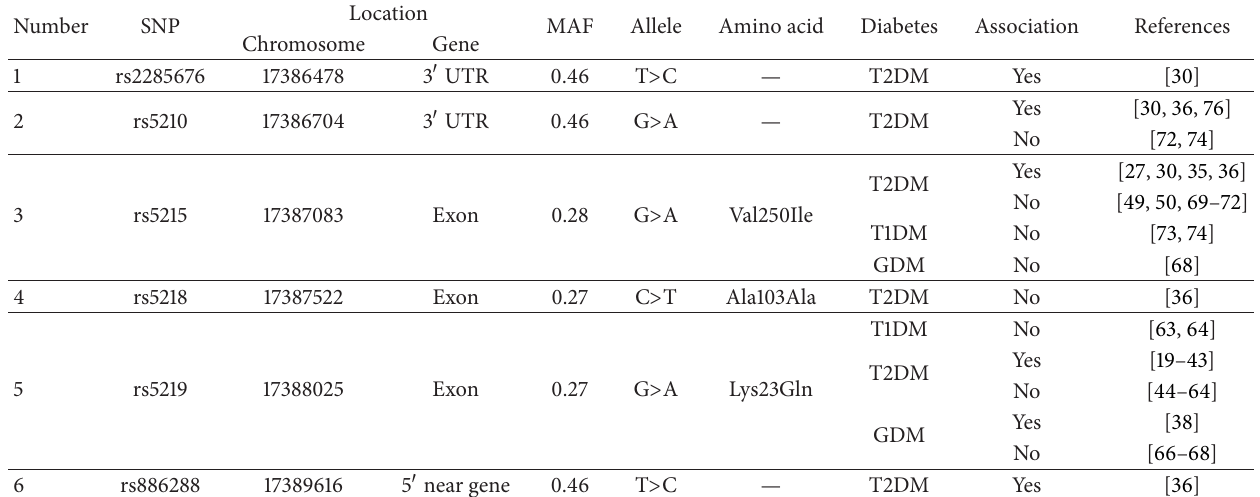
Table 1: Characteristics of KCNJ11 gene variants in association with diabetes mellitus.